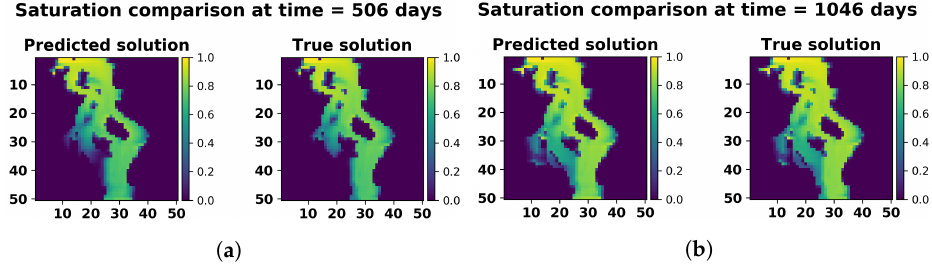
Figure 35. Saturation solution comparison at ( a ) Time = 506 days and ( b ) Time = 1046 days.